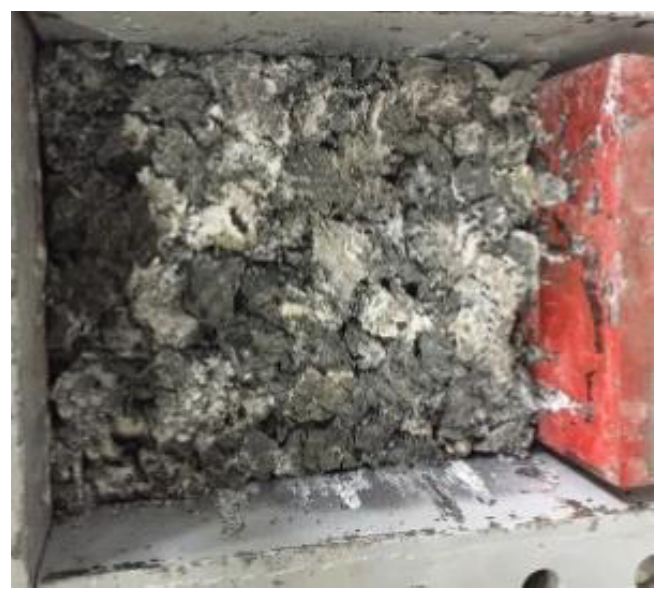
Figure 7. Particle size distribution after compaction.